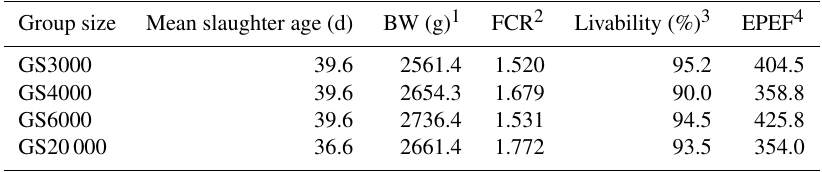
Table 6. Mean slaughter age, body weight, feed intake, feed conversion ratio, and EPEF values at slaughter age in broilers reared in varying group